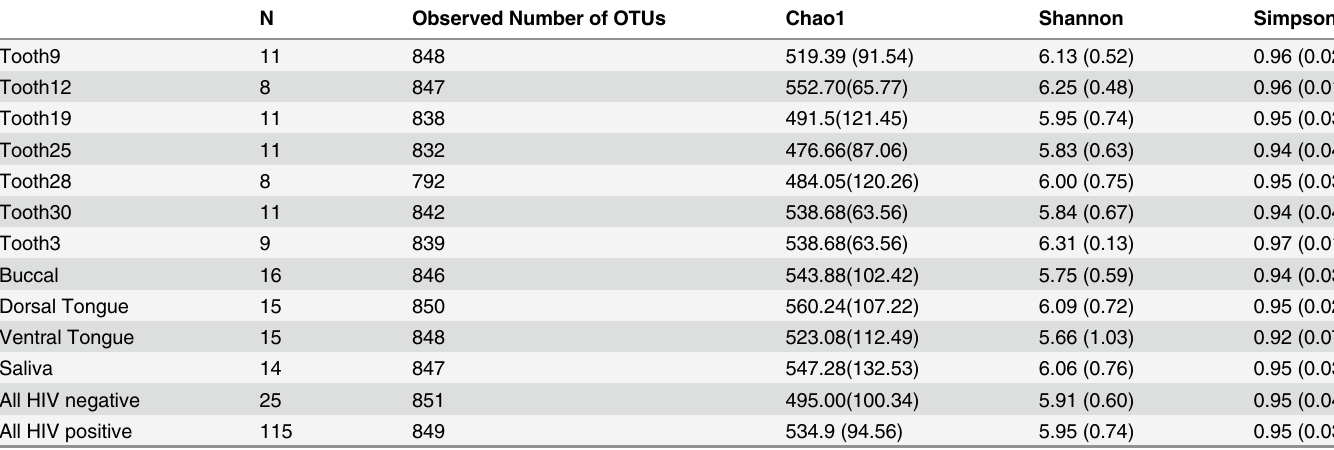
Table 4. Diversity and Richness Estimators a